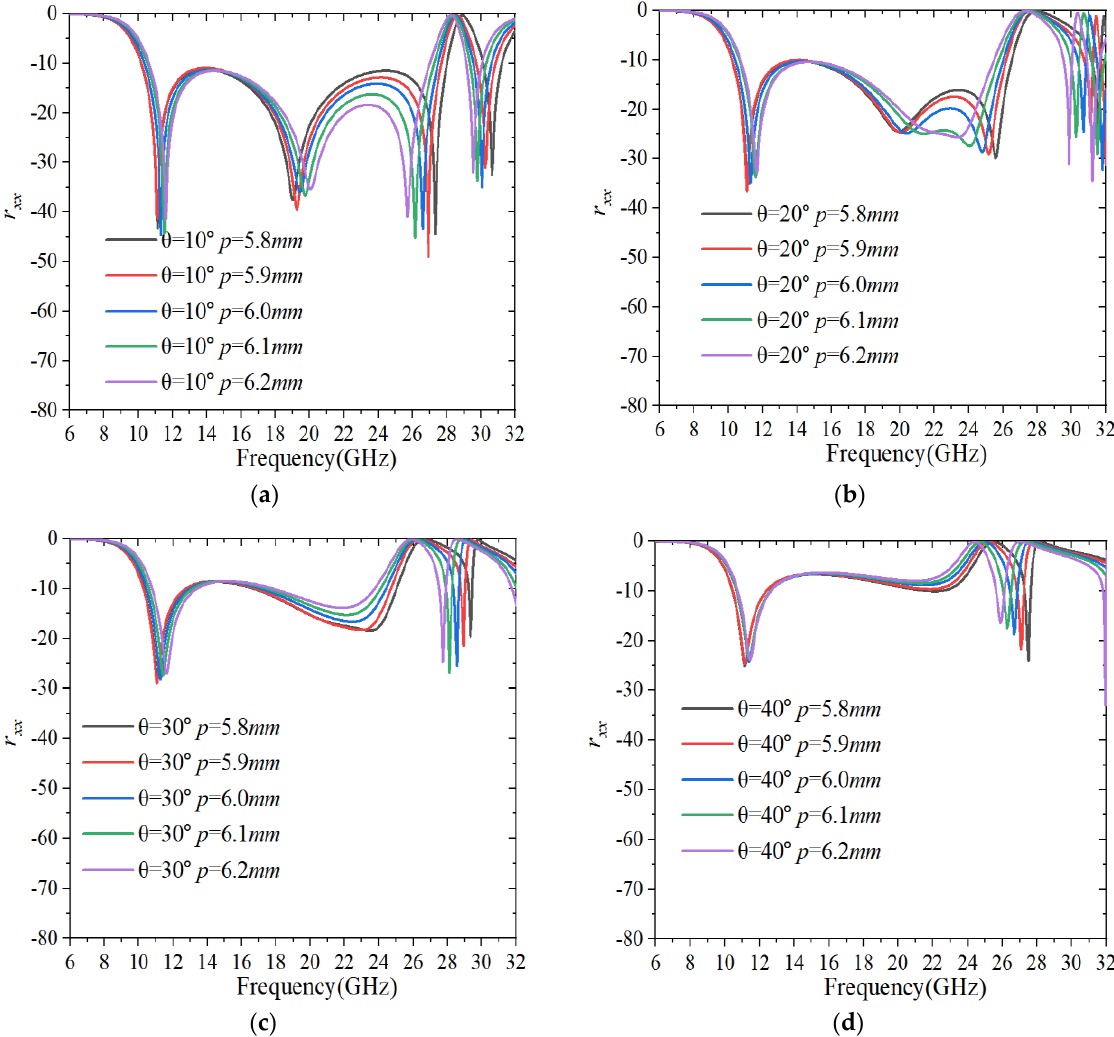
r for normal x -polarization incidence. ( a ) θ = 1 0°; ( b ) θ = 2 0°; ( c ) θ = Figure 6. The amplitudes of Figure 6. The amplitudes of r xx for normal x -polarization incidence. ( a ) θ = 10 ◦ ; ( b ) θ = 20 ◦ ; ( c ) θ = 30 ◦ ; xx ( d ) θ = 40 ◦ 30°; ( d ) θ = 4 0°.